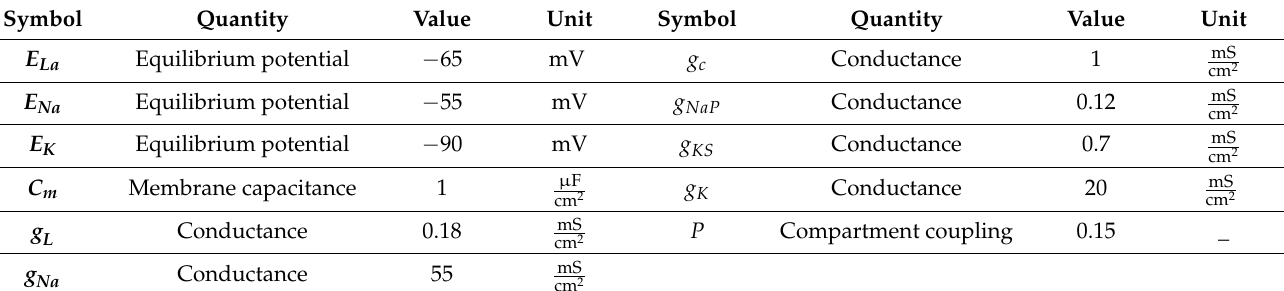
Table A1. Parameter values for the Pinsky–Rinzel